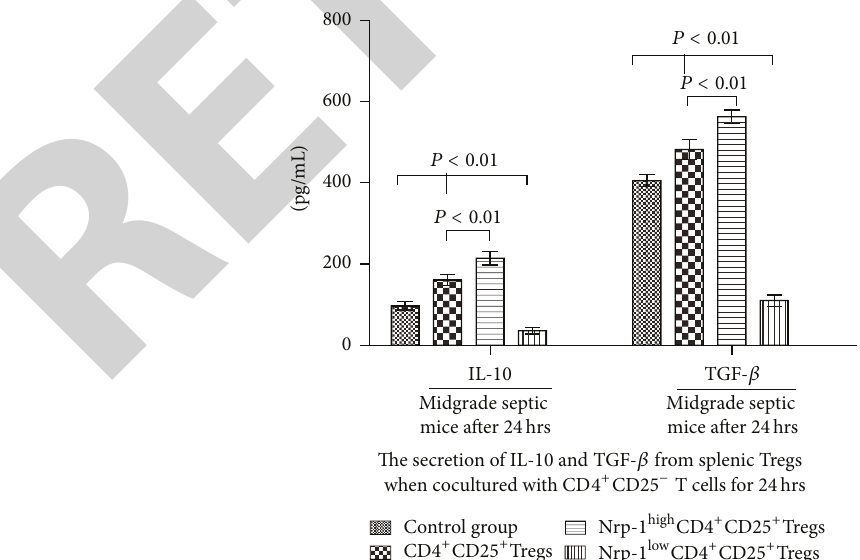
Figure 4: Nrp- 1 high CD4 + CD25 + Tregs showed the strong ability to secrete cytokines. Sepsis could markedly enhance the release of IL-10 and TGF- 𝛽 . Data was represented as mean ± standard deviation (SD) and analyzed by SPSS 17.0 software with a one-way ANOVA, 𝑛 = 4 per group ( 𝑃 < 0.01